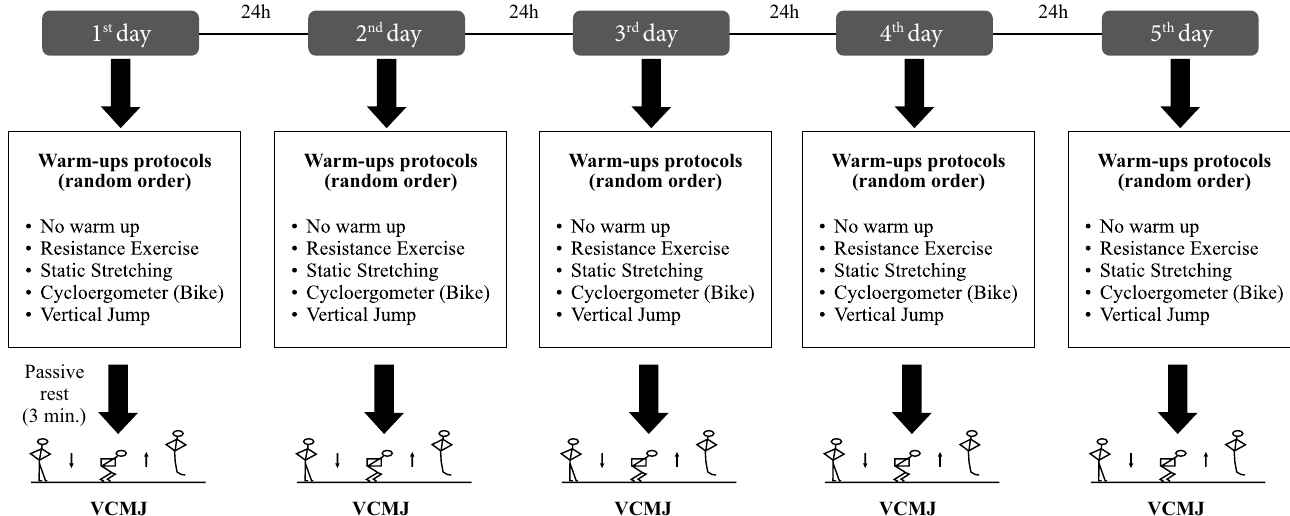
Figure 1. Experimental design of the study (n =